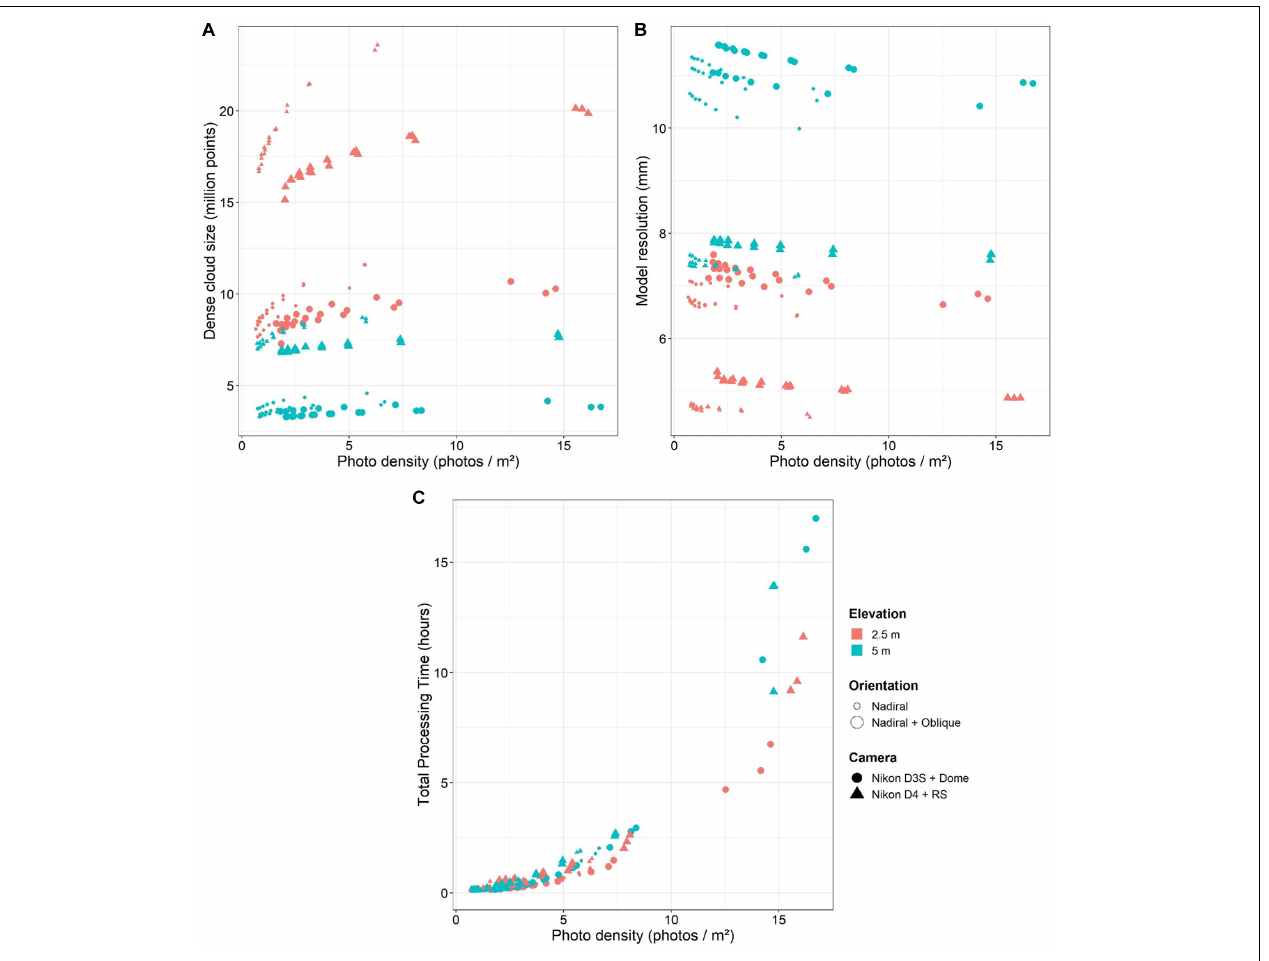
FIGURE 4 | Model statistics in function of the acquisition parameters. (A) Dense cloud size; (B) Model resolution; and (C) Total Processing Time.